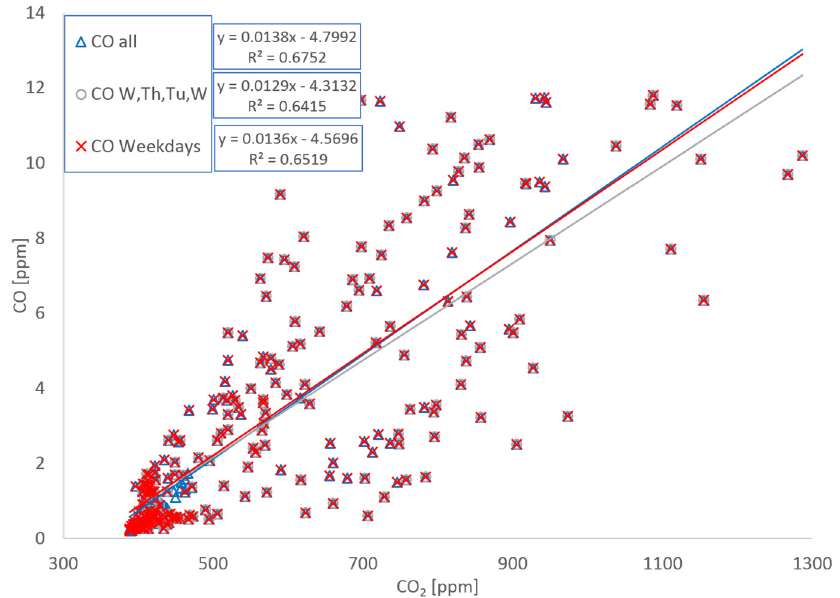
Figure 6. CO plotted against CO 2 for three data sets: all data, all weekday data, all complete 24 h data sets—in this case Wed, Thu, Tue, and 2nd Wed.